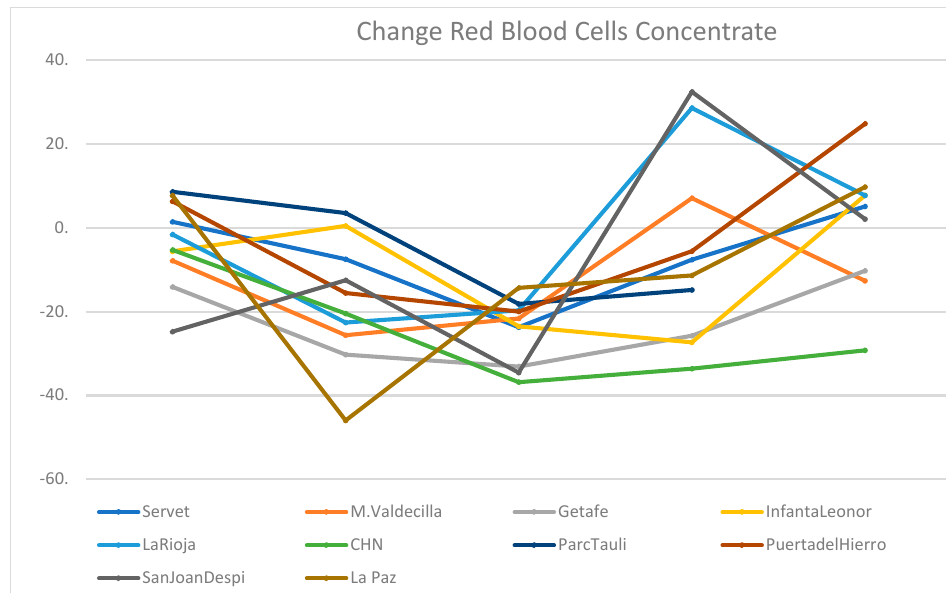
Supplementary Figure A1: Evolution of blood component transfusion in hospital centers as compared with the previous biennium. (CHN, Hospital Complex of Navarra; La